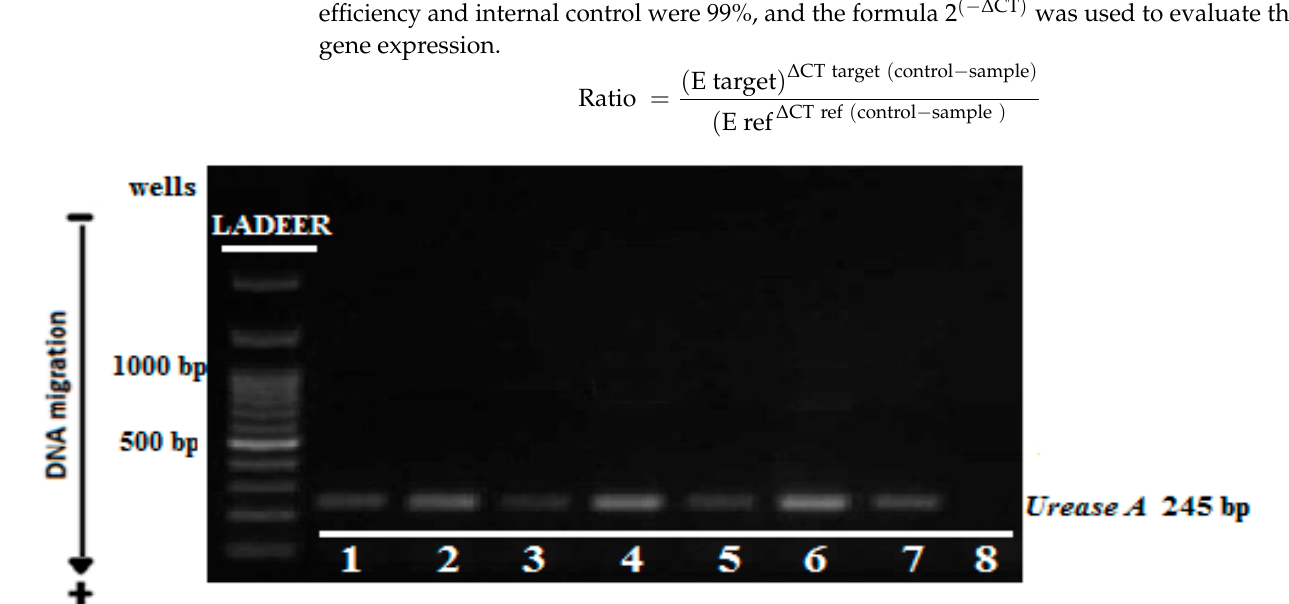
Figure 4. The result of the electrophoresis of urease gene PCR products on agarose gel. Lader: (100 bp); 1: the presence of the urease gene in H. pylori (ATCC 26695) (C+); 2–7: the presence of the urease gene in H. pylori clinical strains; 8: absence of the urease gene in H. pylori clinical strains that were negative for the urease test (C − ).